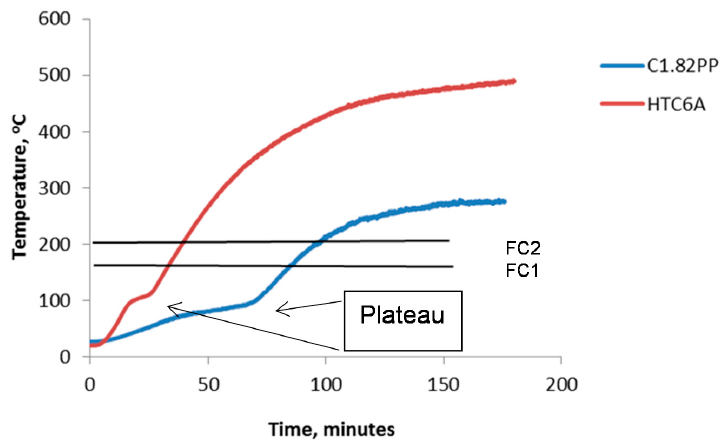
Figure 13. Cold side temperature readings.